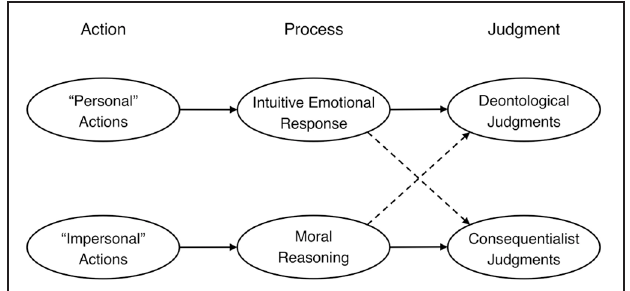
FIGURE 5 | Greene’s dual-process model of moral